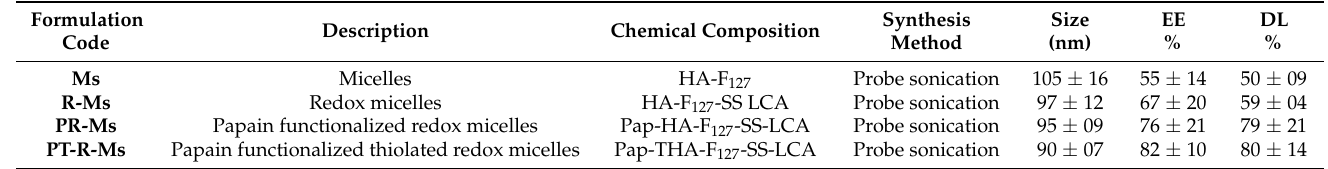
Figure 1. Gaussian particle size distribution obtained by DLS for ( A ) Ms and ( B ) PT-R-Ms. Data are expressed as mean ± SD ( n = 3). Figure 2. Representative TEM images of Ms, R-Ms, PR-Ms, and PT-R-Ms. Table 1. Nomenclature, chemical composition, and characteristics of the different polymeric micelles used in this work. Formulation